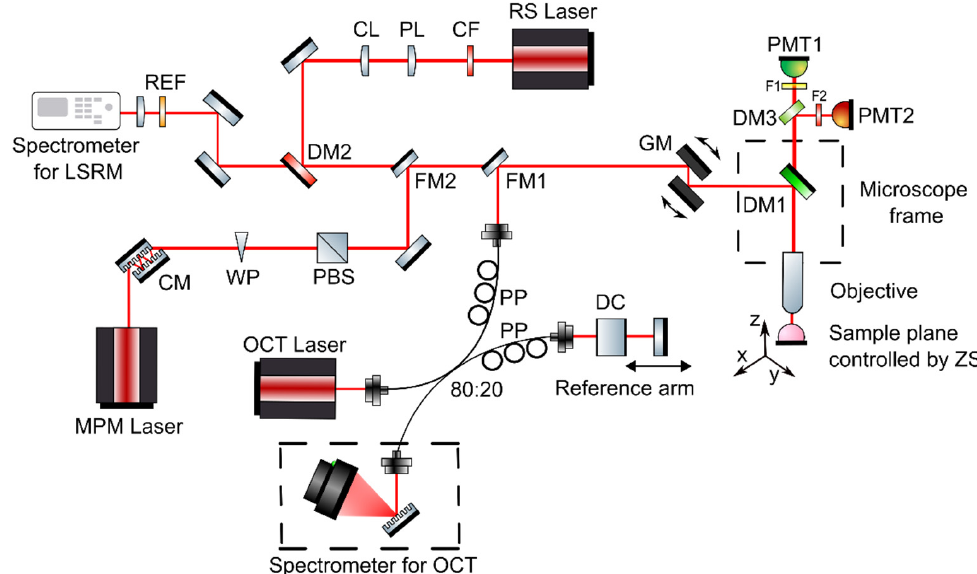
Figure 1. Multimodal optical system featuring OCT, MPM as well as LSRM. The three modalities are coupled into the microscope frame via one common optical path with flipping mirrors. Abbre-